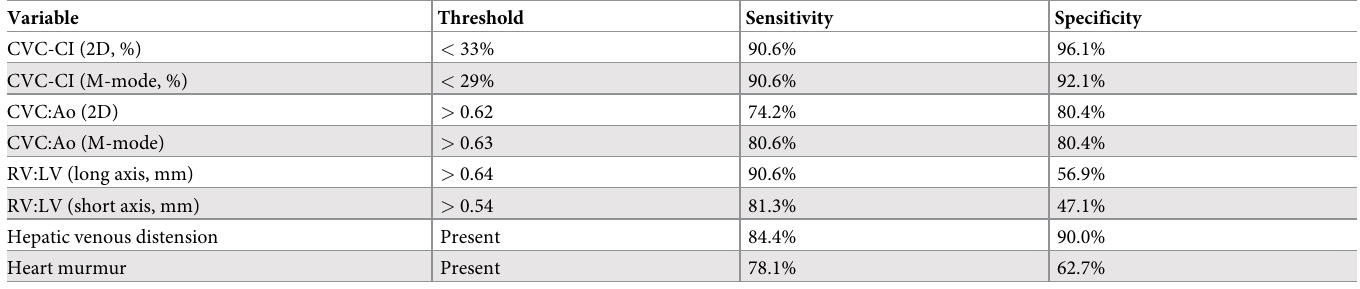
Threshold values indicate cutoff to identify R-CHF. See Table 2 legend for explanation of